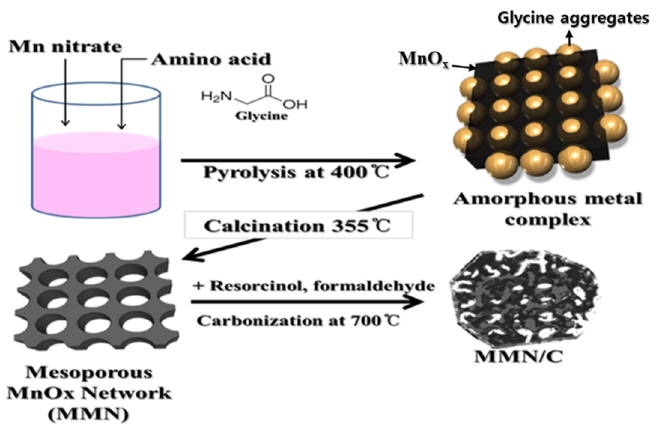
Figure 1. Schematic illustration for the synthesis of MMN and MMN/C composite.